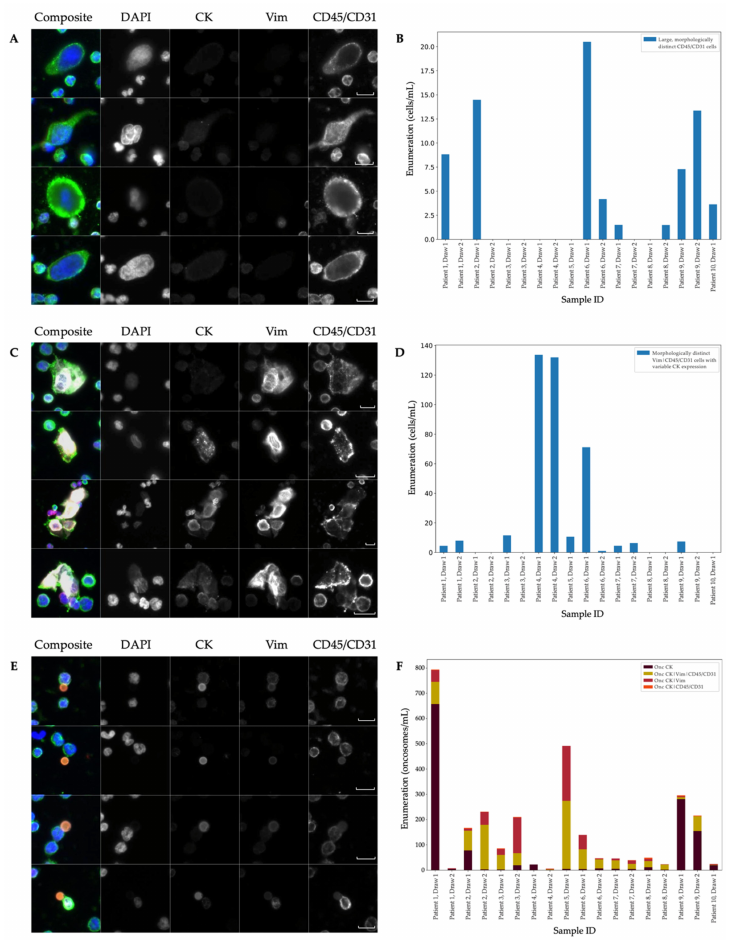
Figure 2. Select rare-event populations in the Landscape-stained metastatic colorectal cancer (mCRC) samples. ( A ) Panel gallery images of the large, morphologically distinct CD45/CD31 cells. ( B ) Large, morphologically distinct CD45/CD31 cell enumeration per patient and draw. ( C ) Panel gallery images of the morphologically distinct Vim|CD45/CD31 cells with variable cytokeratin (CK) expression. ( D ) Morphologically distinct Vim|CD45/CD31 cells with variable CK expression enumeration per patient and draw. ( E ) Panel gallery images of the oncosome population with differential signal expression ( F ) Oncosome enumeration by channel classifications per patient and draw. Images are taken at 400 × magnification. Scale bars represent 10 µ